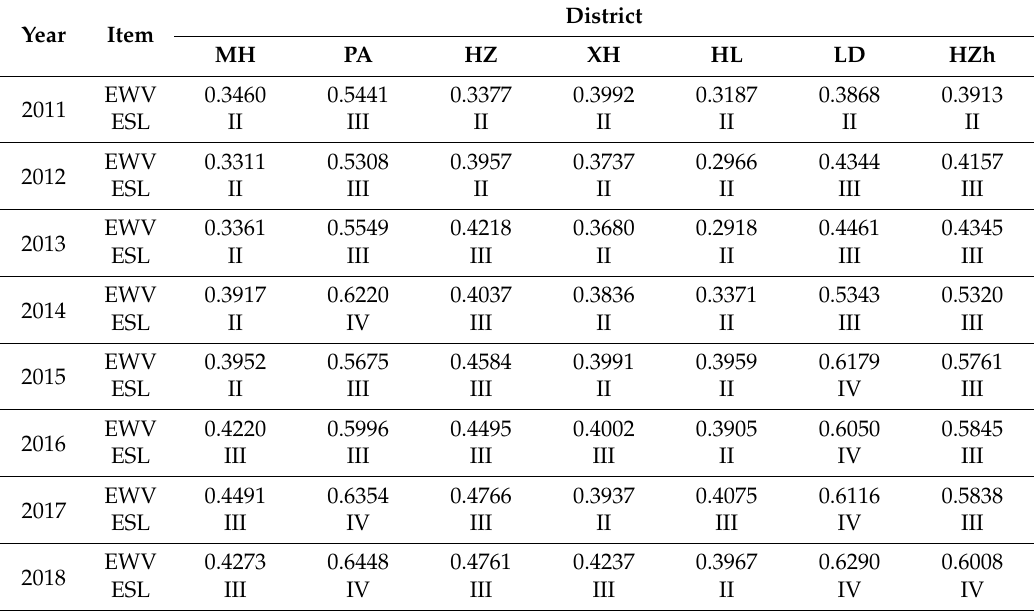
Table 5. Ecological security early-warning values of districts and counties from 2011 to